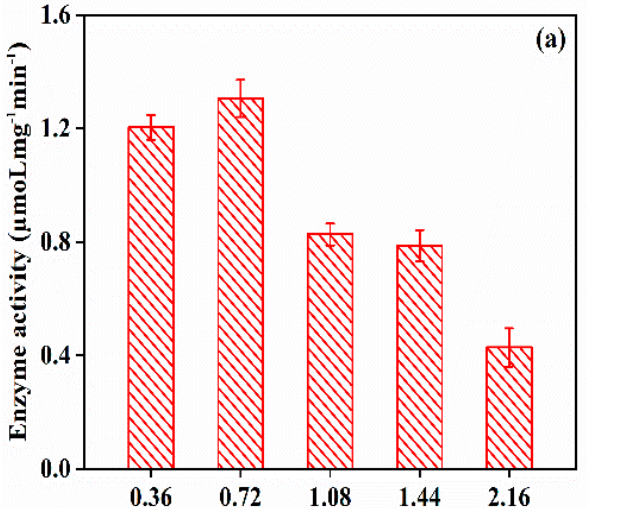
Figure 5. Enzyme activity of CAL-B@PES at different fabrication operating conditions: ( a ) CAL-B concentration, and ( b ) operating pressure .